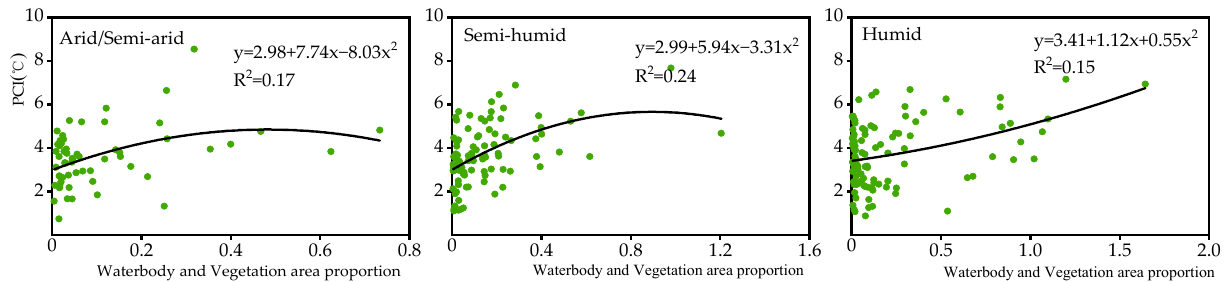
Figure 9. Relationship between PCI and the proportion of waterbody and vegetation area within parks in three climatic regions.